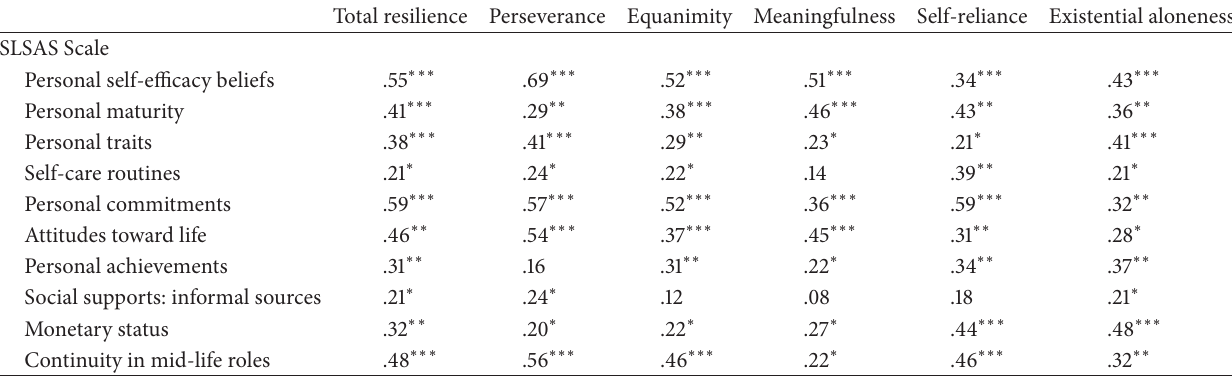
Table 5: Correlation coefficients of SLSAS scales with outcome measures of total resilience, perseverance, equanimity, meaningfulness, self- reliance, and existential aloneness administered at 24-month followup from date of baseline assessment (sample = 150). Total resilience Perseverance Equanimity Meaningfulness Self-reliance Existential